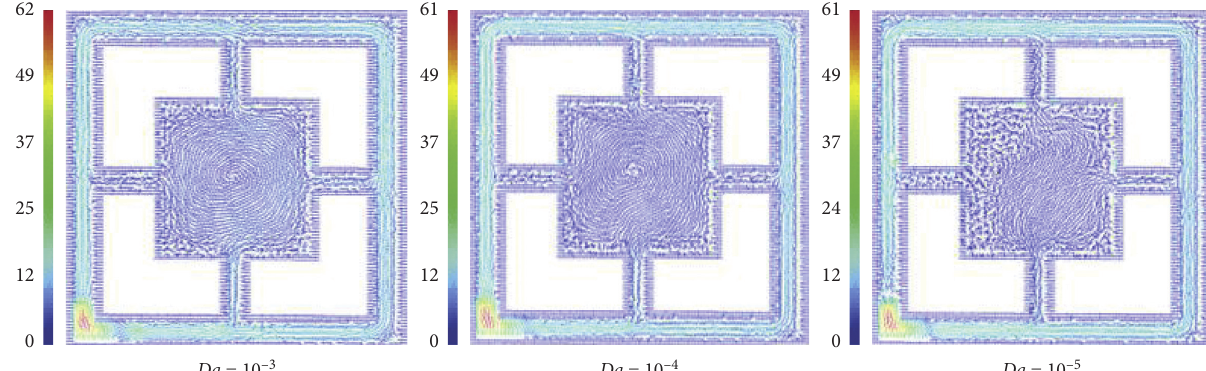
Figure 8: Velocity field below the variations of a Darcy parameter at N � 1 , Ra � 10 4 , ϕ � 0 . 01, η